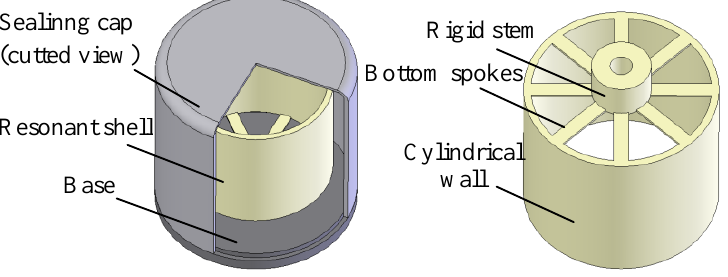
Figure 1. Physical structure of the vibratory cylinder